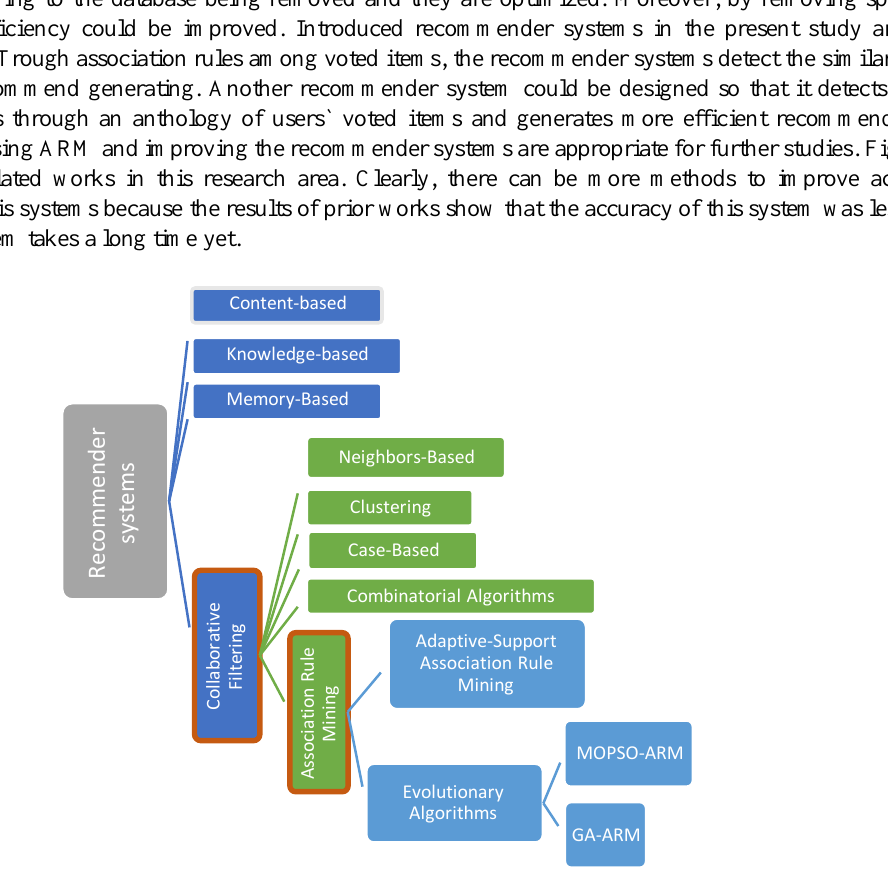
Figure 4. Scope of Evolutionary Association Rule Based Collaborative Recommendation